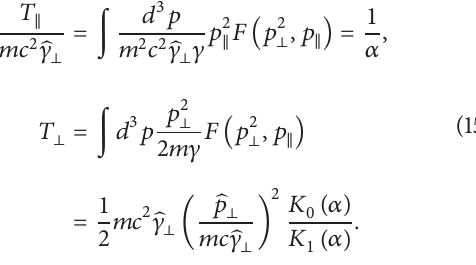
Figure 3: The variation curves of 𝑇 ‖ according to the quantity 𝛼 for different values of ̂𝛾 ⊥